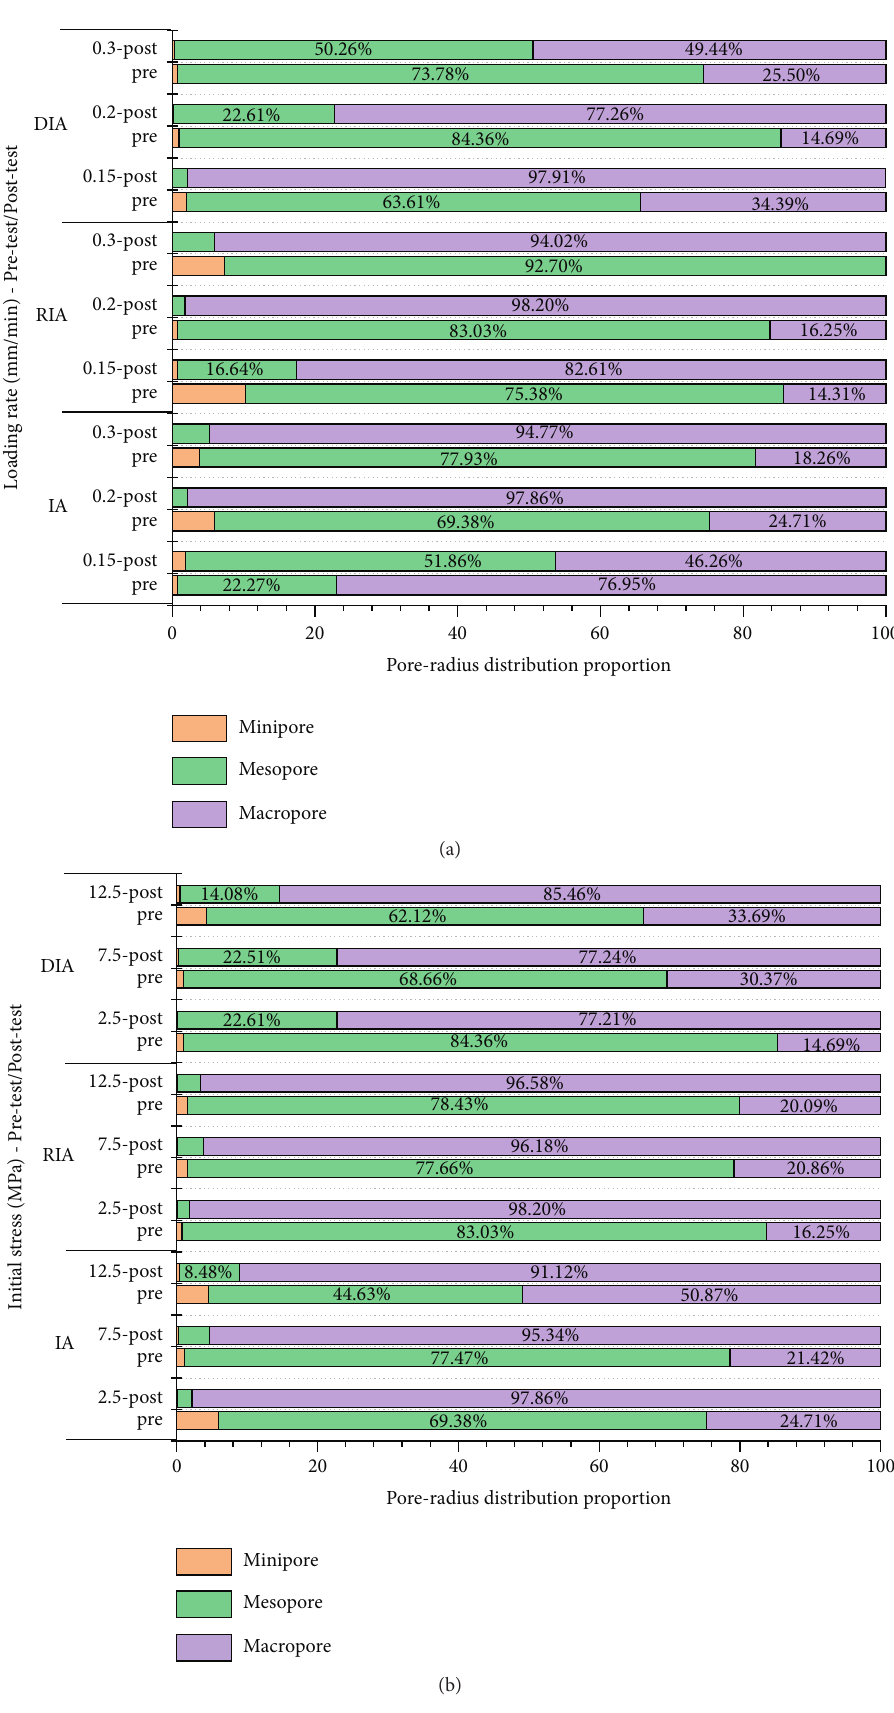
Figure 5: Pore-radius distribution proportion (a) at different loading rates and (b) at different initial peak stresses before and after the